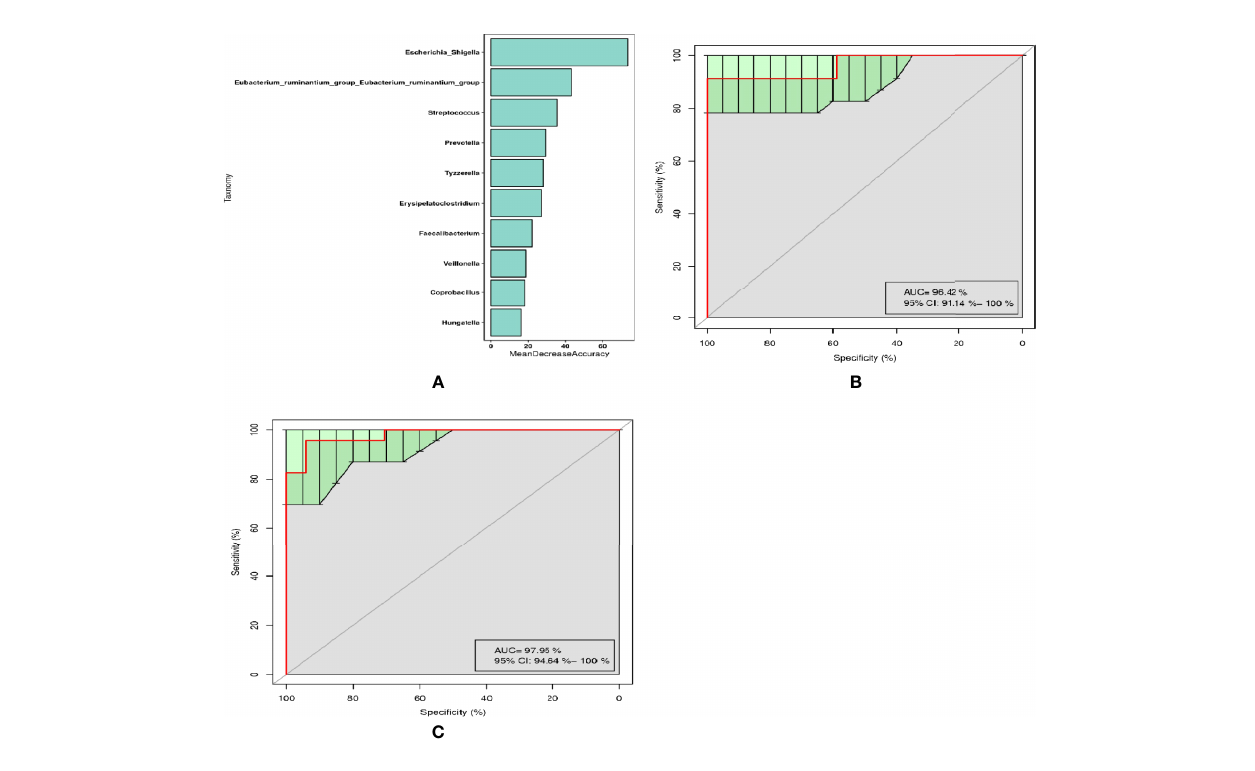
FIGURE 3 | Diagnostic biomarker analysis by a random forest model: (A) Random forest model of the ten microbial genera model. (B) ROC curve of the ten microbial model. (C) ROC curve of the three microbial genera